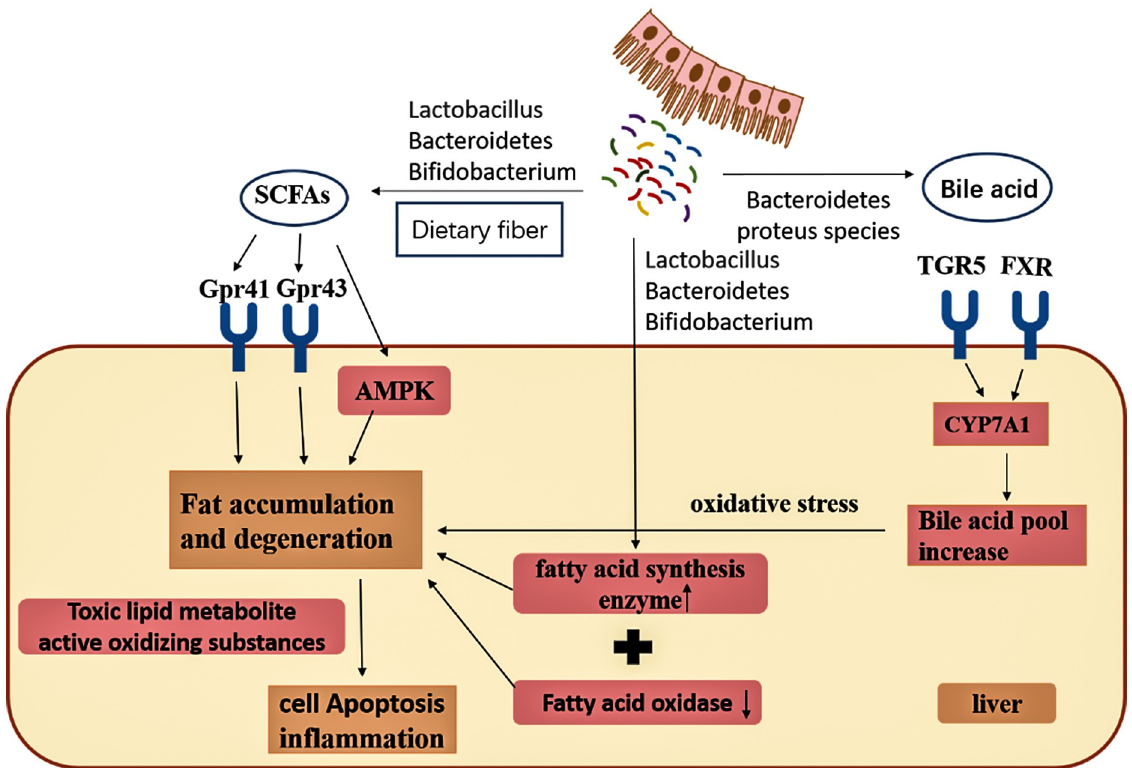
Fig 8. Summary of the pathways for interactions of short-chain fatty acids (SCFAs), bile acids, and the gut microbiome.